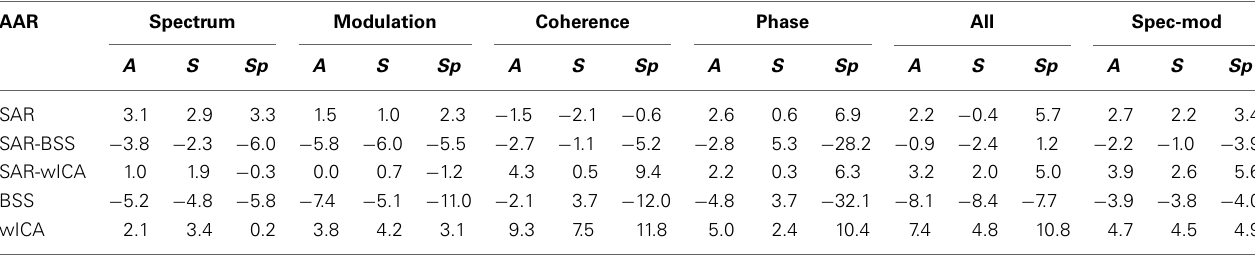
Table 4 | Relative gains obtained after AAR for the 2-class “ AD 1 vs. AD 2” task.